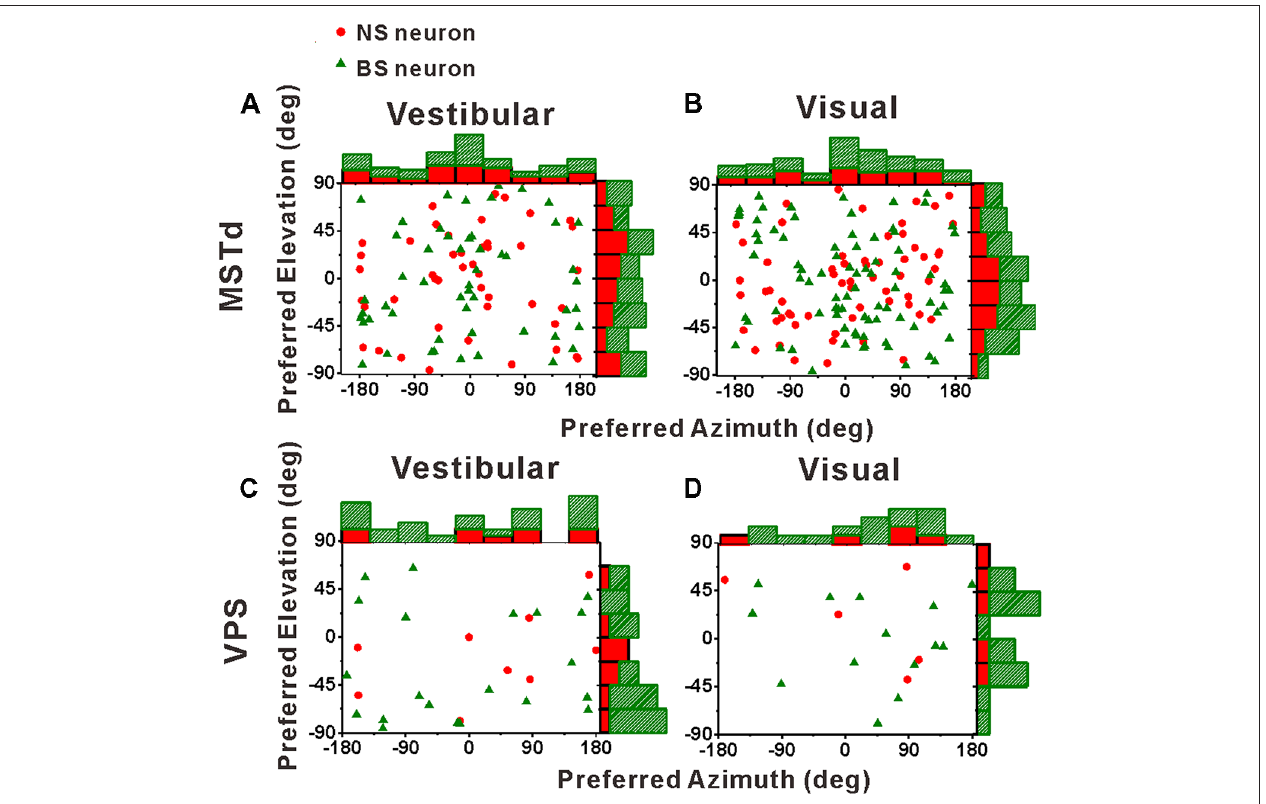
FIGURE 5 | Distributions of 3D heading preferences for NS (red) neurons and BS (green) neurons in areas MSTd (A,B) and VPS (C,D) in response to vestibular and visual stimuli. Each data point in the scatter plot corresponds to the preferred azimuth (abscissa) and elevation (ordinate) of a single neuron with significant heading tuning. Histograms along the top and right sides of each scatter plot show the marginal distributions. The neurons analyzed in the graph have a significant directional tune to vestibular or visual stimuli (both p < 0.05, ANOVA test). The number of neurons were same as in Figure 4